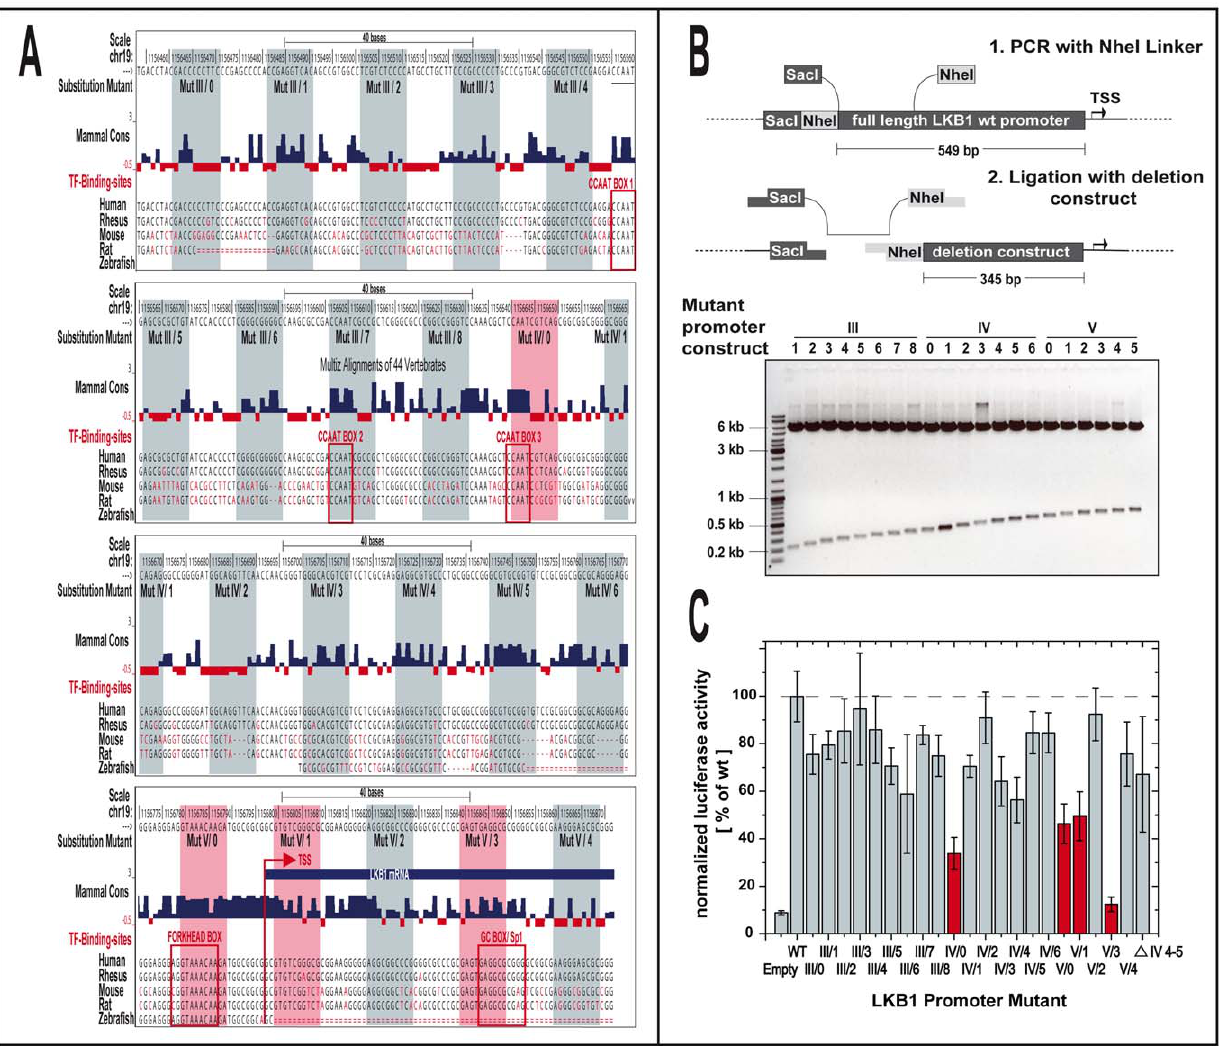
Figure 2. Substitution mutant analysis of the LKB1 promoter. Match of phylogenetic footprint with substitution mutant analysis of the LKB1 promoter region ranging from nucleotide position 2 345 to + 75. ( A ) Mammalian base-wise conservation (blue and red bars) is displayed together with sequence alignments of different species, predicted transcription factor (TF)-binding sites (red boxes) and positions of mutations within the corresponding substitution mutants of the LKB1 promoter reporter constructs. Conserved sequences (‘‘Mammal Cons’’) are indicated in blue, non- conserved sequences in red. The height of the corresponding bars represents the degree of conservation. Mutations which reduce reporter activity in the substitution mutant analysis by more than 50% are highlighted in a light red background, while mutations without influence on reporter activity are coloured in a light blue background. Display of alignments and mammalian conservation were modified from the UCSC genome browser (see Fig. 1). The positions of the potential CCAAT/Forkhead/Sp1 boxes are indicated as red rectangles. ( B ) Substitution mutants of the LKB1 promoter Pro II fragment, encompassing nucleotides 2 549 to + 727, were constructed by introducing a 10 bp mutation, comprising a NheI restriction site, within the area of 2 345 to + 75 by PCR and religation with the respective deletion mutant. The presence of the mutation within the LKB1 promoter was monitored by agarose gel electrophoresis following restriction enzyme digestion with SacI and NheI. ( C ) Luciferase activity of transiently transfected ‘‘444’’ cells with LKB1 promoter 10 bp substitution mutants reveals a critical role of four cis -acting elements regulating LKB1 transcription (red bars). Activity of substitution mutants (relative light units normalized against renilla luciferase activity) is expressed as the percentage of the signal obtained with the plasmid containing the LKB1 wild-type promoter (LKB1 Pro II, 2 549 to + 727). Each bar represents the means 6 standard deviation of three independent experiments made in quadruplicate.